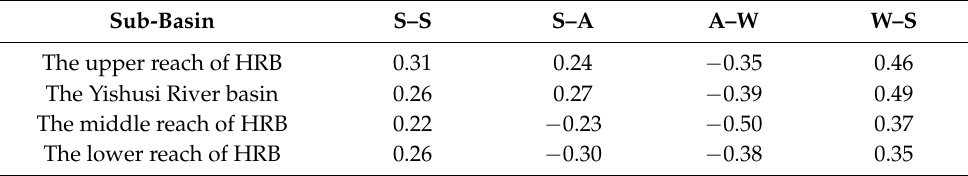
Table 5. Kendall’s tau correlation coefficient of the MSDI in adjacent seasons.